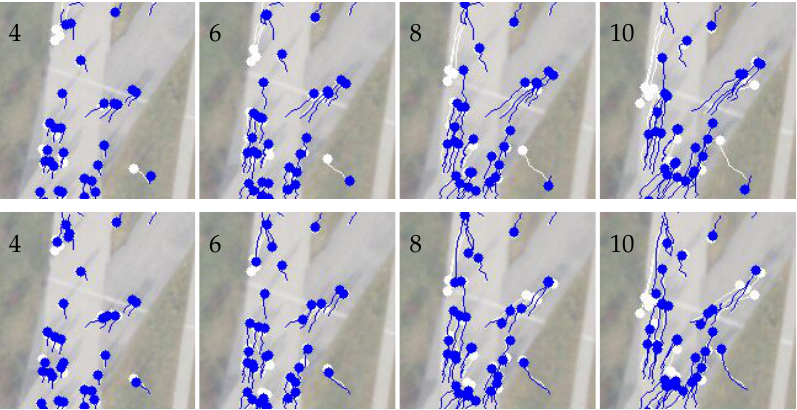
Figure 14. Tracking results by AerialMPTNet ( top row ) and SMSOT-CNN ( bottom row ) on the frames 4, 6, 8, and 10 of the “AA_Crossing_02” sequence of the KIT AIS pedestrian dataset. The predictions and ground truth are depicted in blue and white,